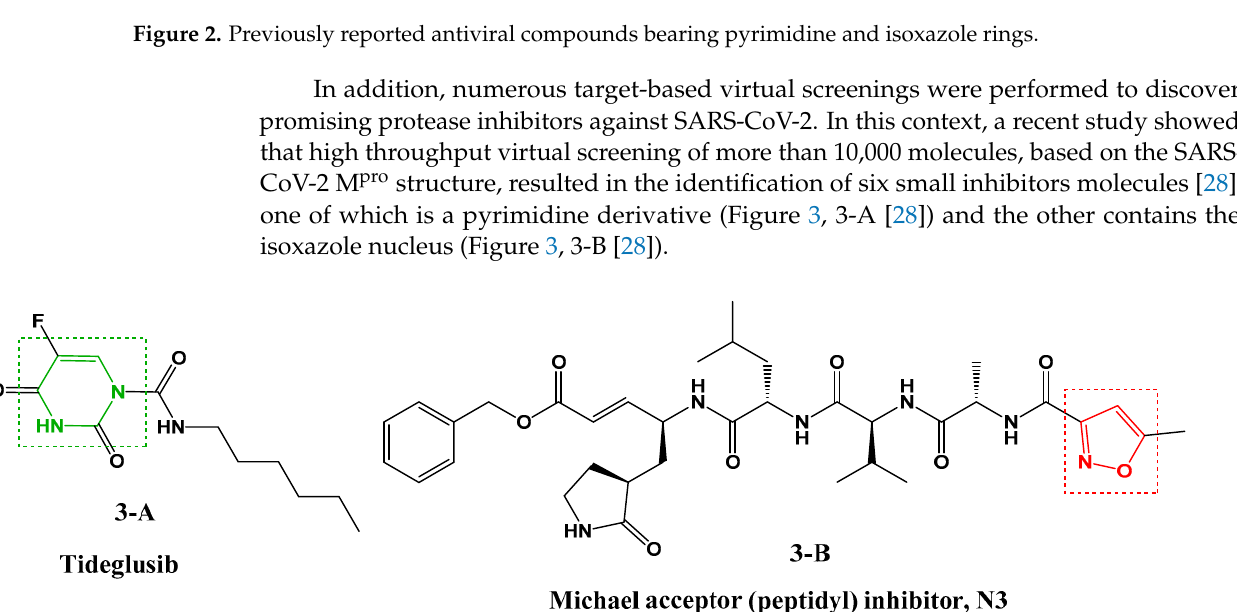
Figure 3. Structure of SARS-CoV-2 M pro inhibitors.